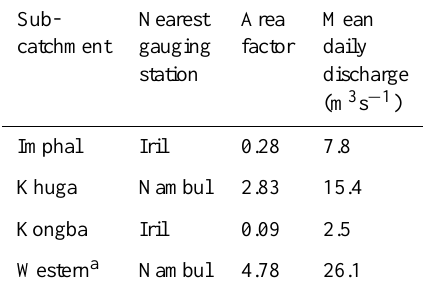
Table 4. Simulated mean daily flows of ungauged